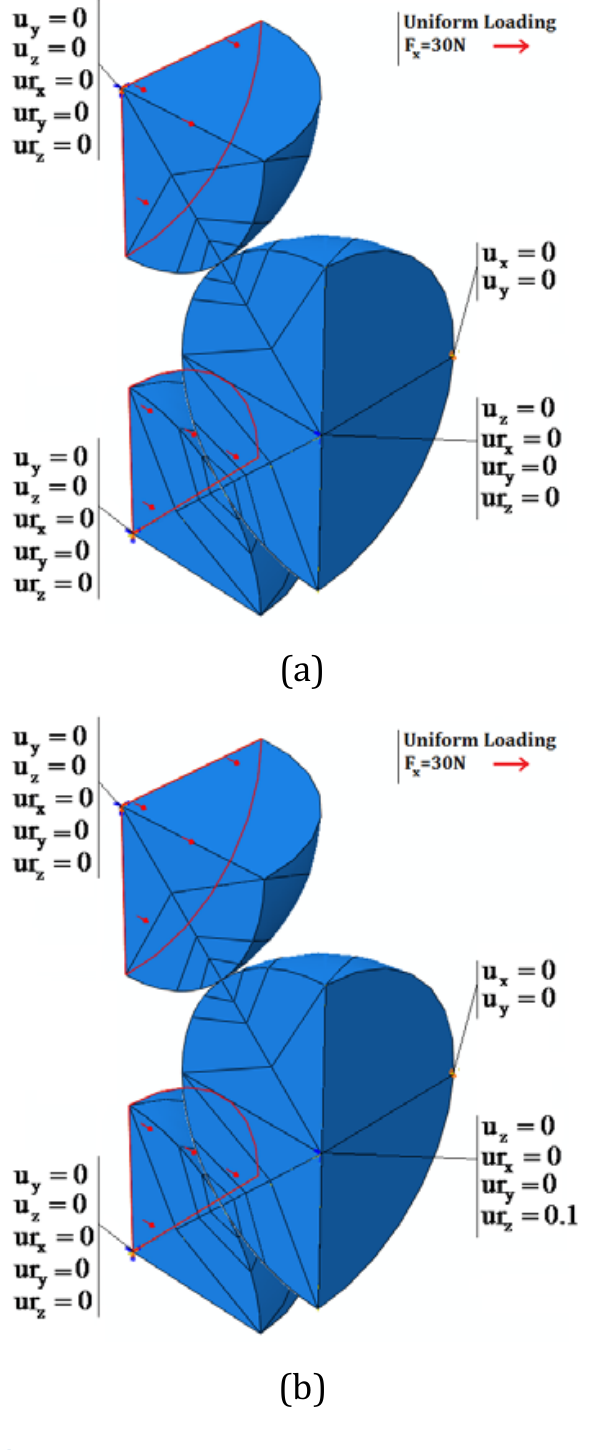
Figure 5. BCC model boundary conditions and loads in static (a) and dynamic (b) phases (rotation in radians).